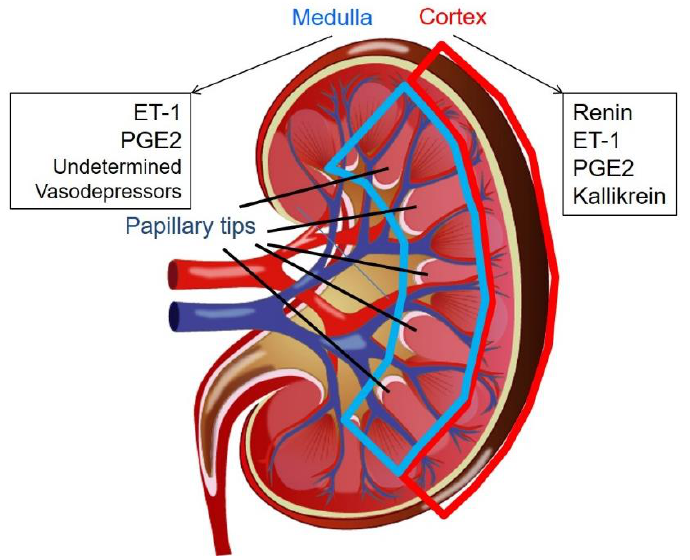
Figure 3. The vasopressors and vasodepressors derived from the kidneys. ET-1, endothelin 1; PGE2, prostaglandin E2.